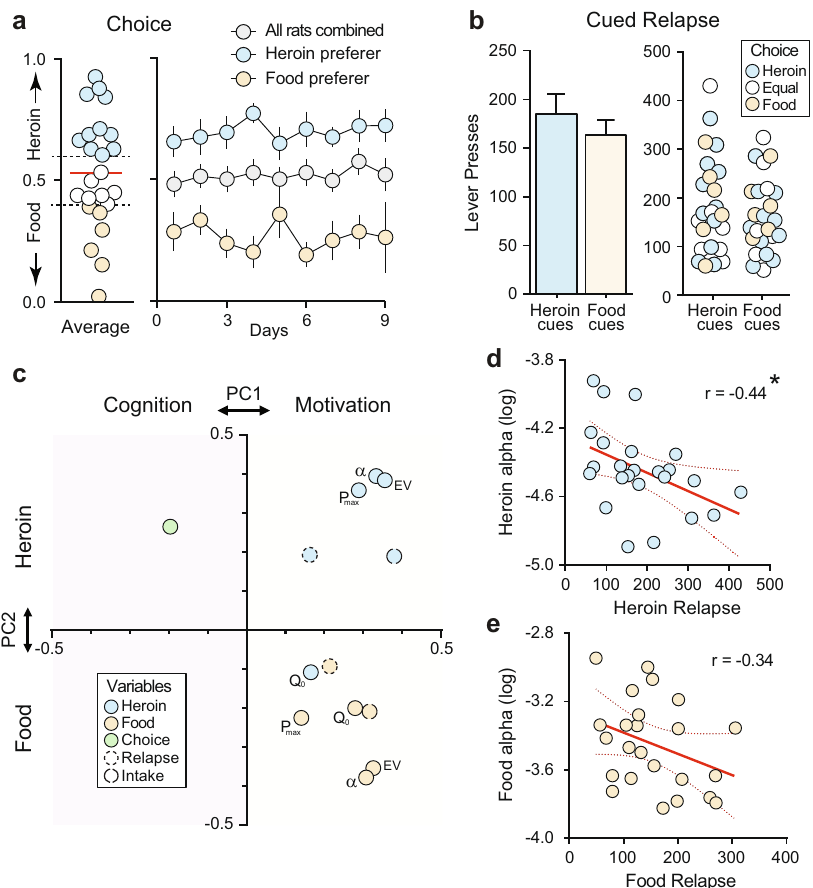
Fig. 2 Heroin choice and relapse are distinct behaviors. a Overall rats choose food and heroin equally, with a subset of rats preferring heroin (>60% heroin choice, n = 11 rats) versus food (>60% food choice, n = 6 rats). b Rats reinstate food and heroin cues equally, and relapse does not differ between food and heroin preferring animals. c Heroin relapse clusters with heroin variables and food relapse with food variables (and heroin Q 0 ), but the choice is distinct from these variables in principal component space. Blue colors indicate heroin variables, orange food variables, and choice is labeled green. d Heroin α negatively correlates with heroin relapse (Pearson ’ s r = − 0.44, p = 0.03). e Food α does not correlate with food relapse n = 24 rats ( a – e ). * p < 0.05 signi fi cant correlation. Data were presented as mean ± SEM ( a , b ). IL → NAshell spines encode heroin choice and relapse . At the end of the experiment, structural analyses were performed on dendritic segments from IL → NAshell neurons (using the mCherry tag on the DREADD, Fig. 6a). Spine density (Fig. 6b) and morphology (Fig. 6f) were measured as the number of spines per dendritic segment or the average spine head diameter per dendritic segment, respectively. This analysis revealed bidirec- tional relationships between these structural measures and heroin versus food reinforcement. IL → NAshell neuron spine density positively correlated with food relapse (Fig. 6c; r = 0.68, p = 0.043) and negatively correlated with food (log) α value (Fig. 6d; r = − 0.67, p = 0.047). Further analysis of the cumulative frequency distribution of inter-spine intervals (the space between individual spines) revealed a difference between heroin versus food pre- ferers, with food preferers having signi fi cantly smaller inter-spine intervals (Fig. 6e; KS2 = 0.07, p = 1.29 × 10 − 5 ). By contrast, spine morphology correlated with measures of heroin, but not food, motivation. Spine head diameter positively correlated with heroin relapse (Fig. 6g; r = 0.71, p = 0.030) and negatively correlated with heroin (log) α value (Fig. 6h; r = − 0.68, p = 0.043). No